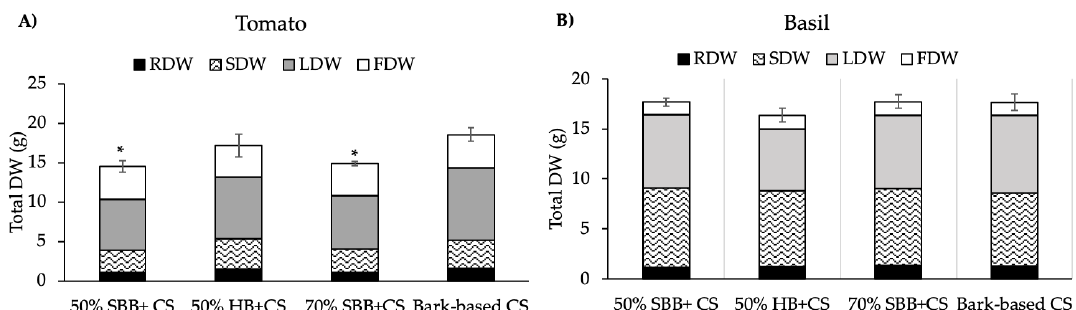
Figure 5. Total dry weight (Total DW = root dry weight (RDW) + shoot dry weight (SDW) + leave dry weight (LDW) + fruit dry weight (FDW); mean ± standard error) of tomato ( A ) and basil ( B ) grown in container mixes with 50% sugarcane bagasse biochar (SBB), 50% mixed hardwood biochar (HB), and 70% SBB (by vol.) mixed with bark-based commercial substrate (CS). *indicated significant differences on the total DW from CS using Dunnett’s test at p ≤ 0.05.